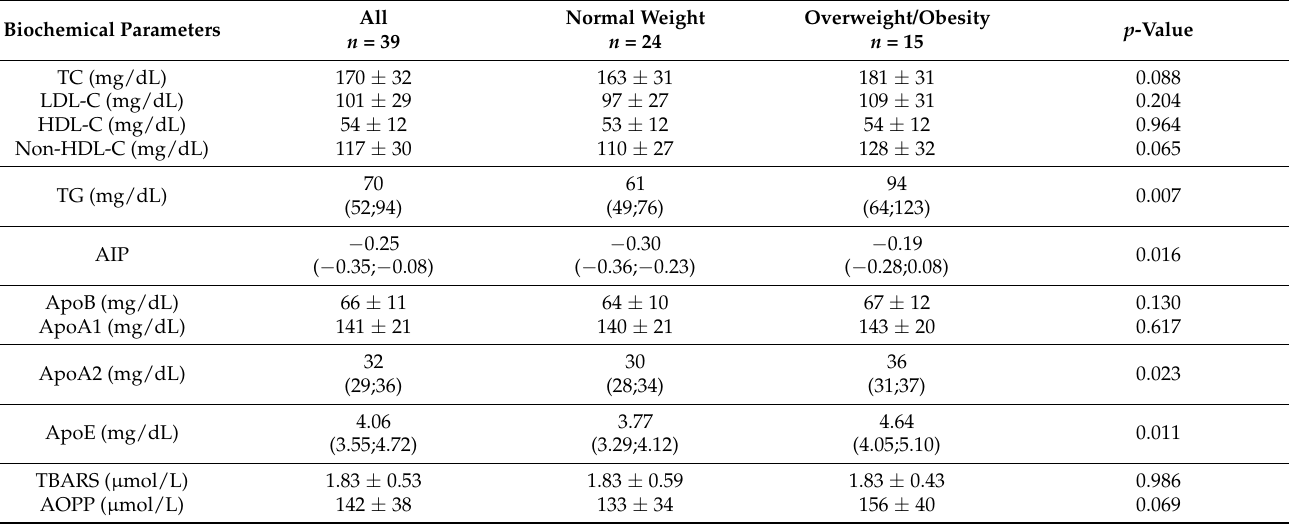
Table 2. Analysis of differences in biochemical parameters between children with normal weight and excess body mass.